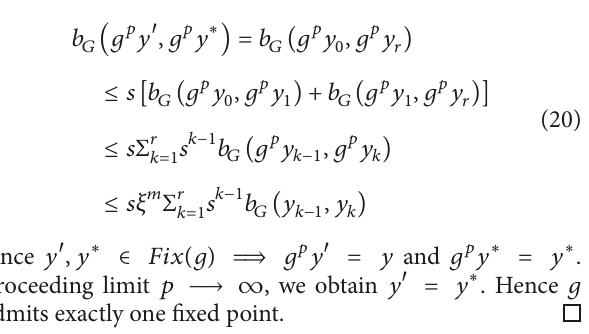
Figure 5: Weighted graph for U 󸀠 ( G ) where 𝑏 𝐺 (𝑦 1 , 𝑦 2 ) = weight of edge (𝑦 1 ,𝑦 2 )